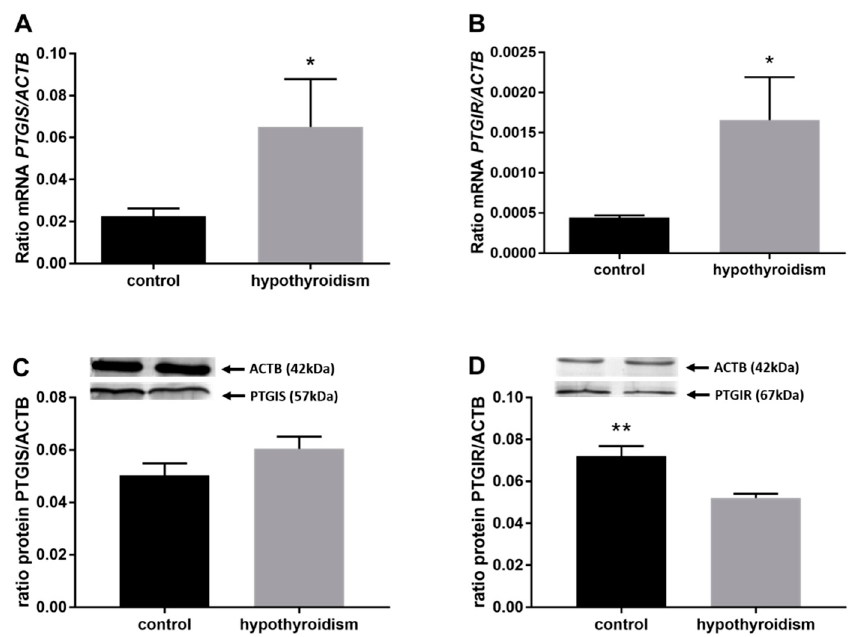
Figure 8. The effects of hypothyroidism on the mRNA and protein abundance of PGI 2 synthase and its receptor in the uterine tissue of rats: ( A , C ): PGIS/PGIS; ( B , D ): PTGIR/PTGIR. The values are presented as arbitrary units and expressed as the mean ± SEM. Stars indicate significant differences (* p ≤ 0.05, ** p ≤ 0.01, *** p ≤ 0.001, **** p ≤ 0.0001), as determined by Student’s t -test.